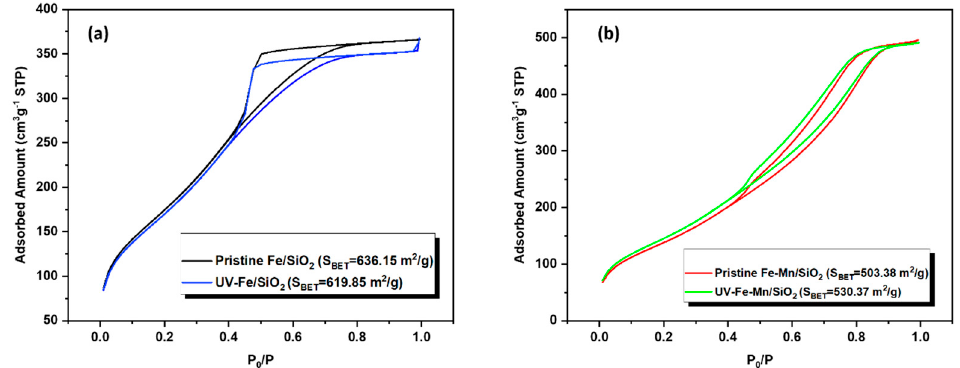
Figure 12. N 2 adsorption–desorption curve ( a ) pristine and UV − irradiated Fe 2 O 3 /SiO 2 (Fe/SiO 2 ) ( b ) Fe 2 O 3 − Mn 2 O 3 /SiO 2 (Fe − Mn/SiO 2 ).